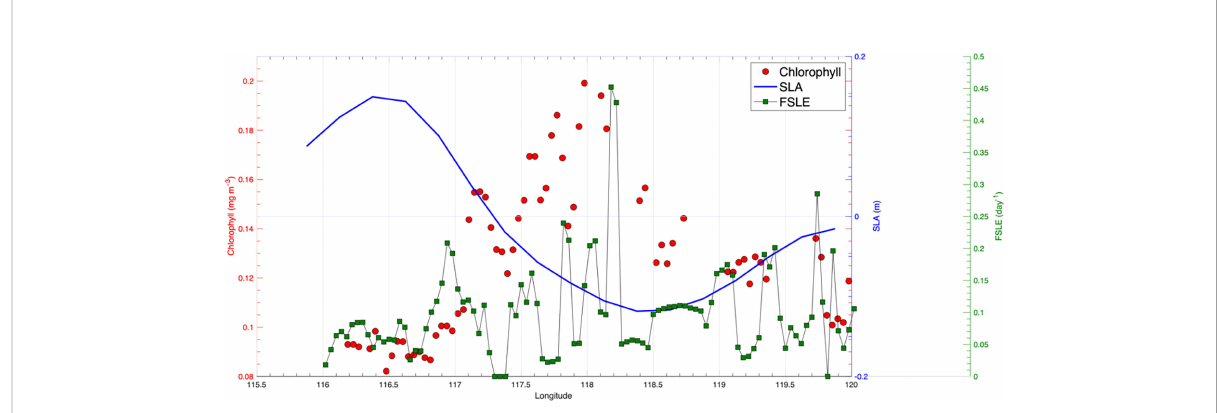
FIGURE 3 Spatial variability of SLA (units: m), surface chlorophyll concentration (units: mg m -3 ), and FSLE (units: day -1 ) along the transect shown in Figure